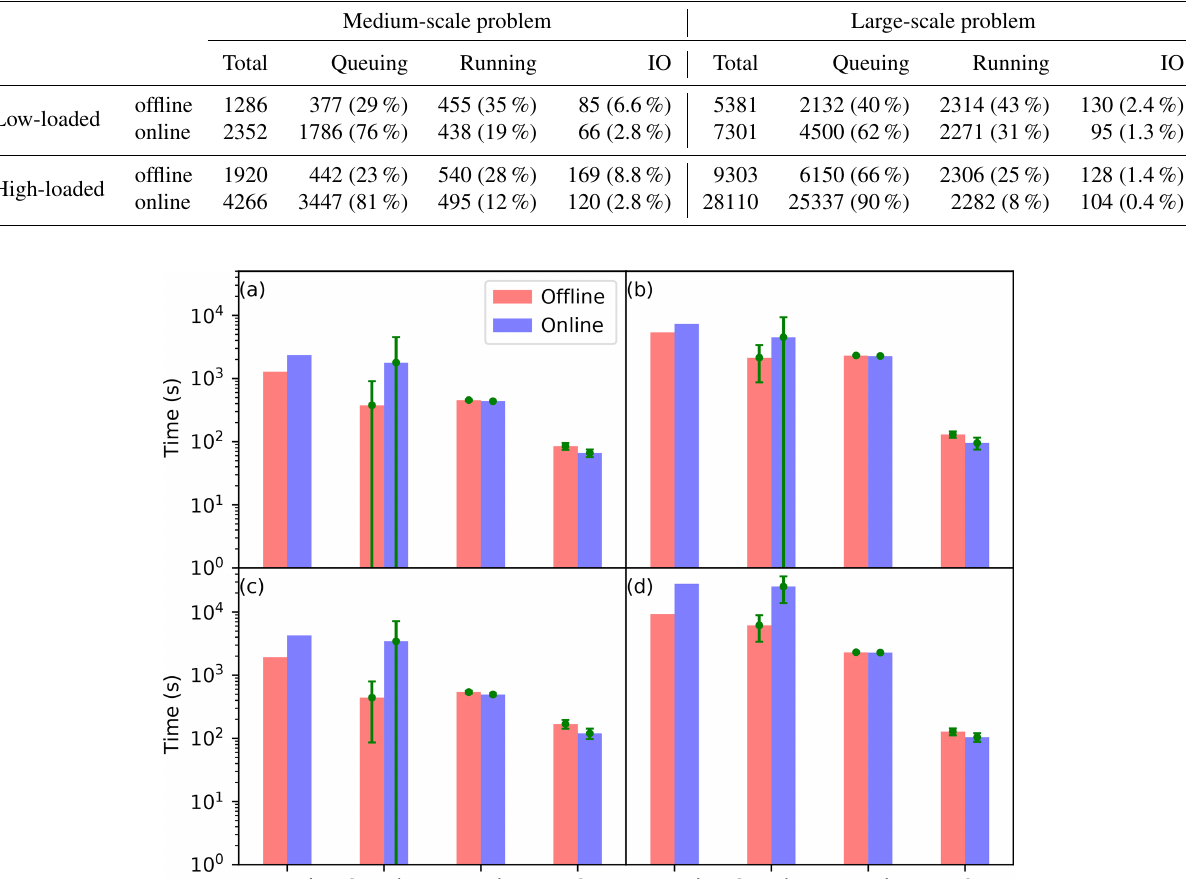
Figure 10. The average total time, queuing time, running time, and IO time of the offline (red bars) and online (blue bars) EnKFs for the low- loaded (a, b) and high-loaded (c, d) conditions. The left panels (a, c) and right panels (b, d) are for the medium- and large-scale problems, respectively. The green line indicates the corresponding standard